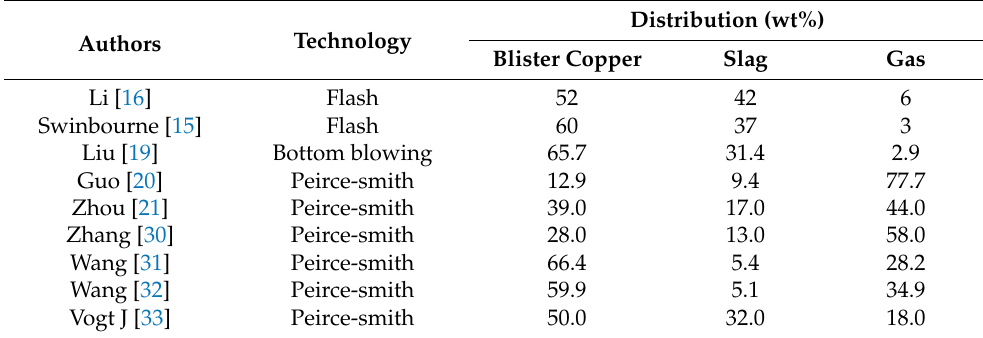
Table 1. The published data on arsenic distribution during converting.